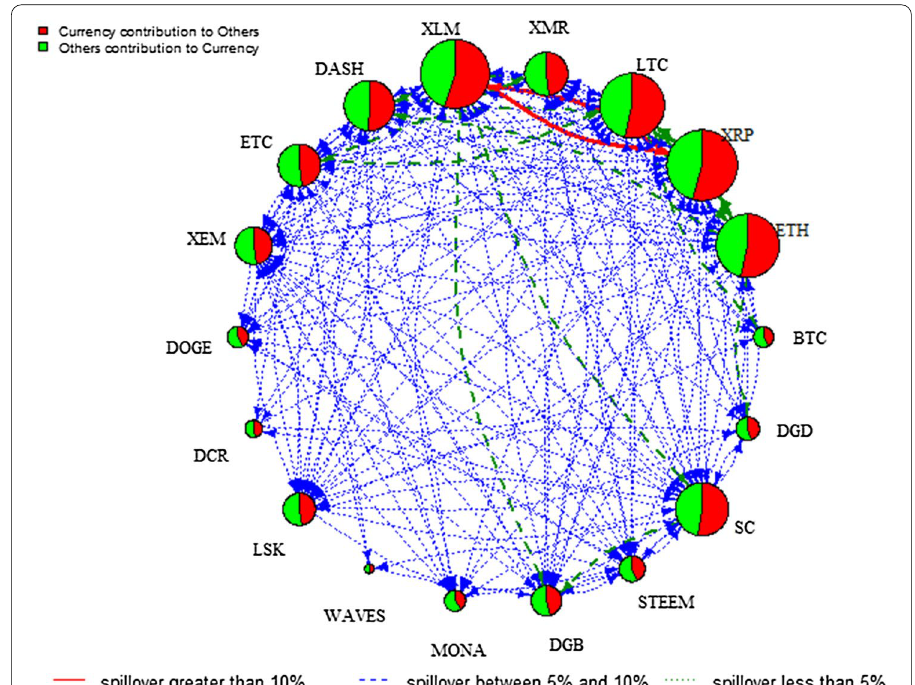
Fig. 4 DY spillover network—low volatility regime. Note : See notes to Fig. 2